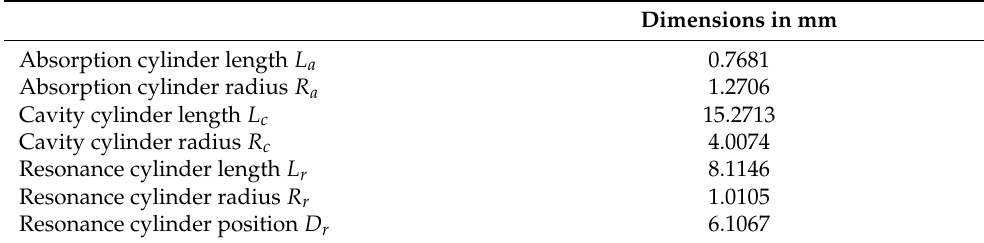
Table 1. Resonator